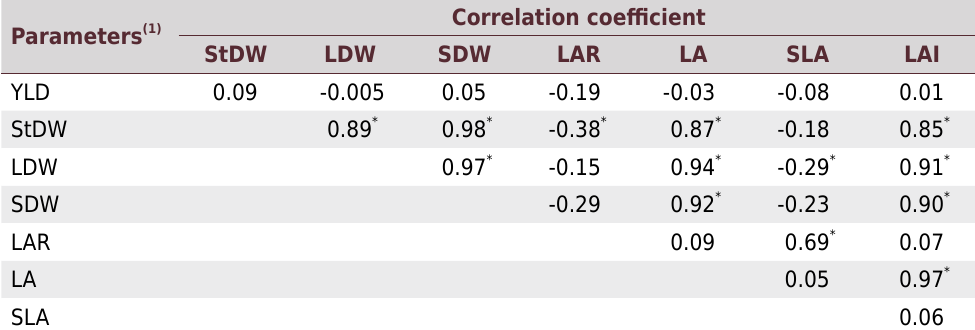
Table 3. Simple linear correlation matrix between soybean yield and the biometric parameters in the first crop (2015/2016) Parameters